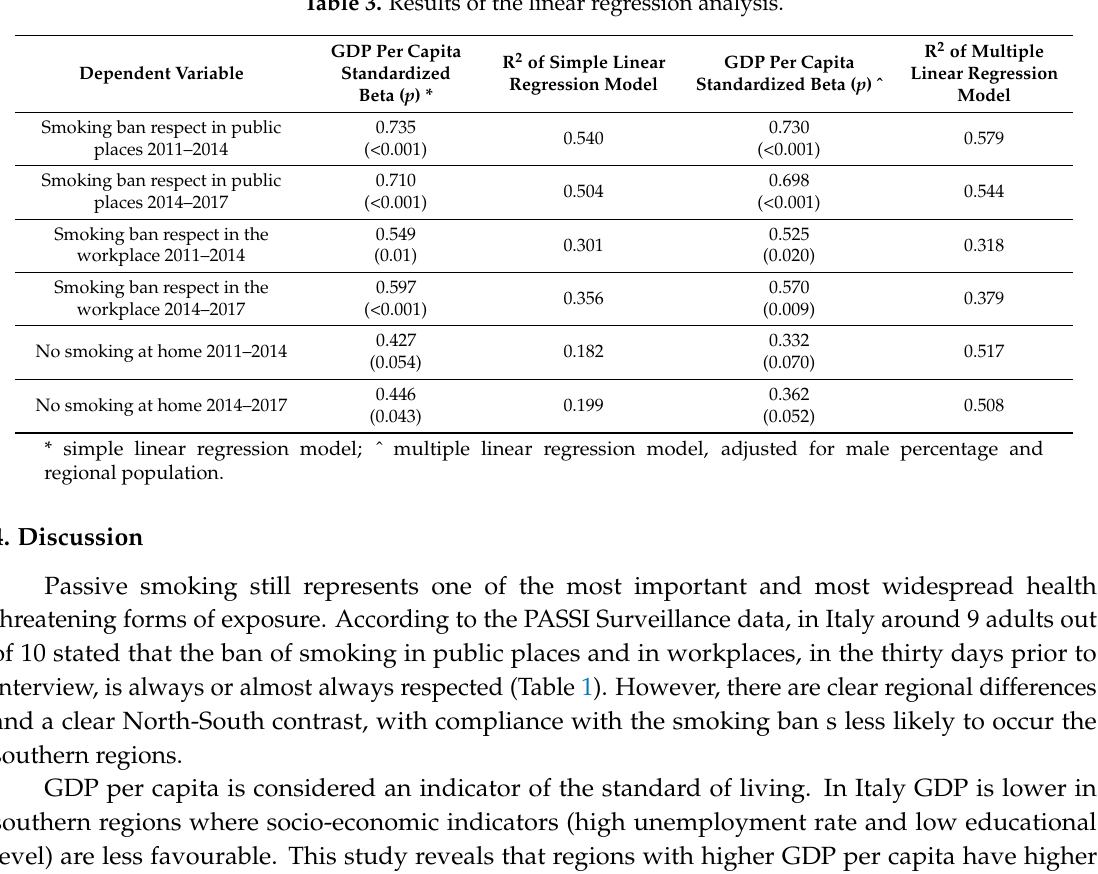
Table 3. Results of the linear regression